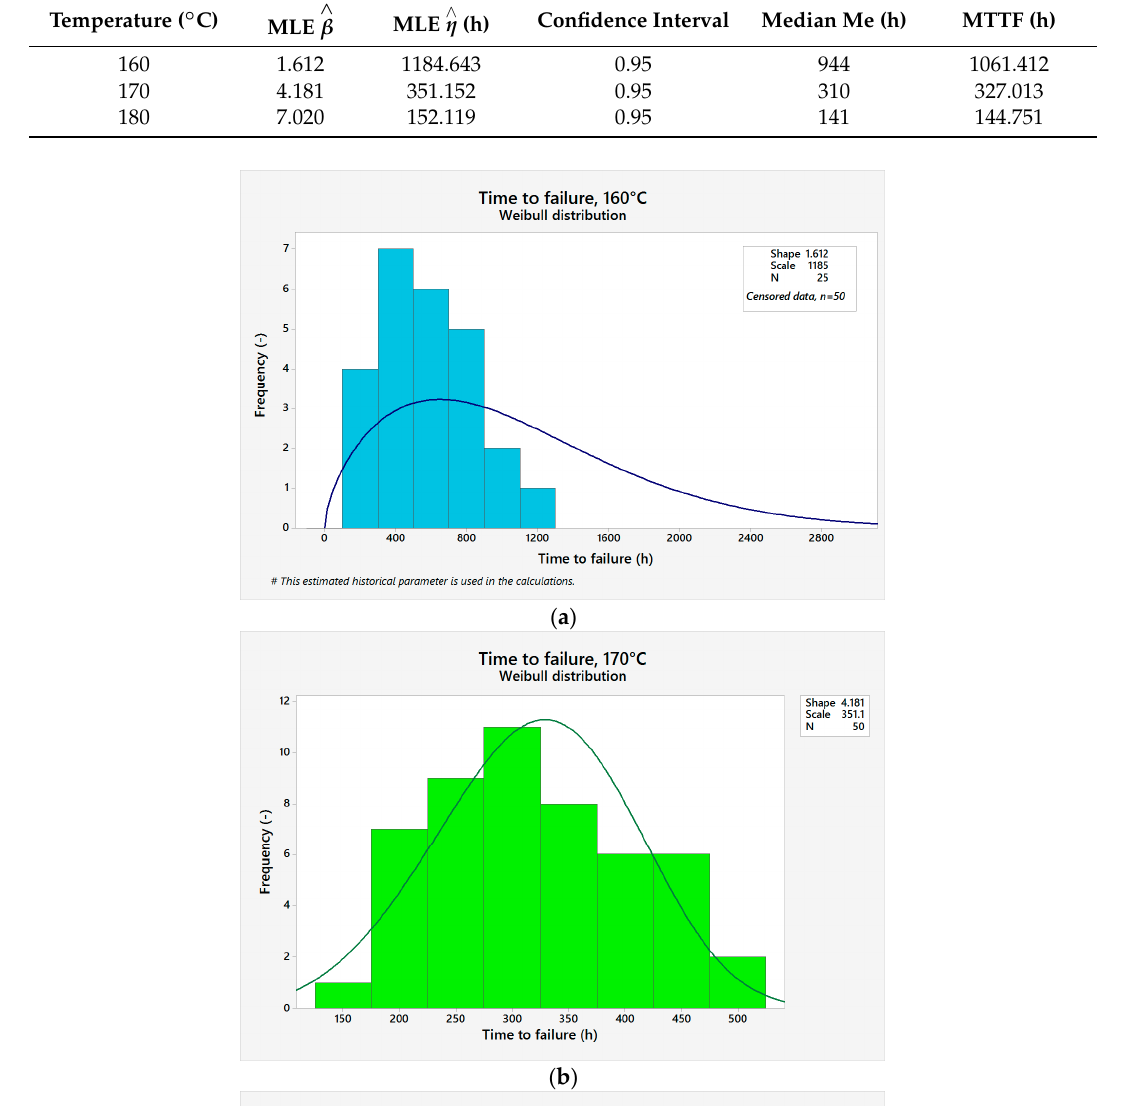
Table 2. Estimation of individual parameters of the Weibull distribution for different temperature.